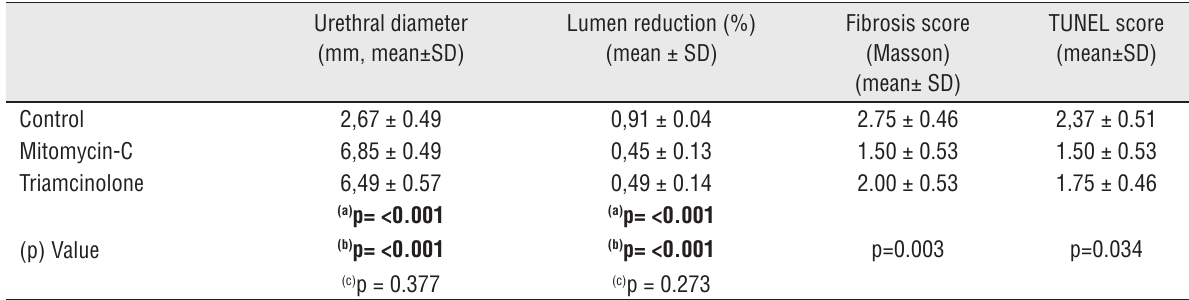
Table 1 - Urethral diameter, lumen reduction rate of rabbits in different treated groups.